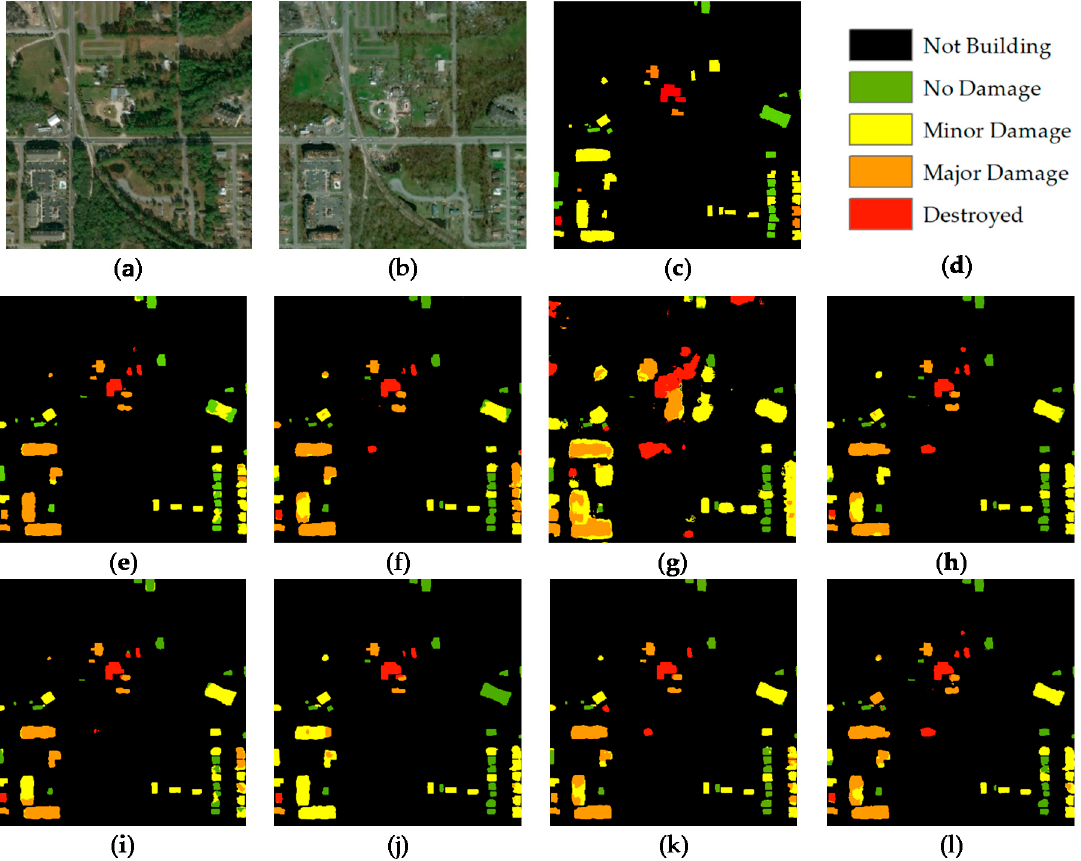
Figure 10. Hurricane-michael_00000256 in the verification set. ( a ) A pre-disaster image, ( b ) a post-disaster image, ( c ) the ground truth (GT) and ( d ) the legend. ( e ) The result of ResNet (w/o A or without attention), ( f ) the result of SEresNeXt (w/o A), ( g ) the result of DPN (w/o A), ( h ) the result of the Squeeze-and-Excitation network (SENet) (w/o A), ( i ) the result of ResNet (w A or with attention), ( j ) the result of SEresNeXt (w A), ( k ) the result of DPN (w A) and ( l ) the result of SENet (w A).